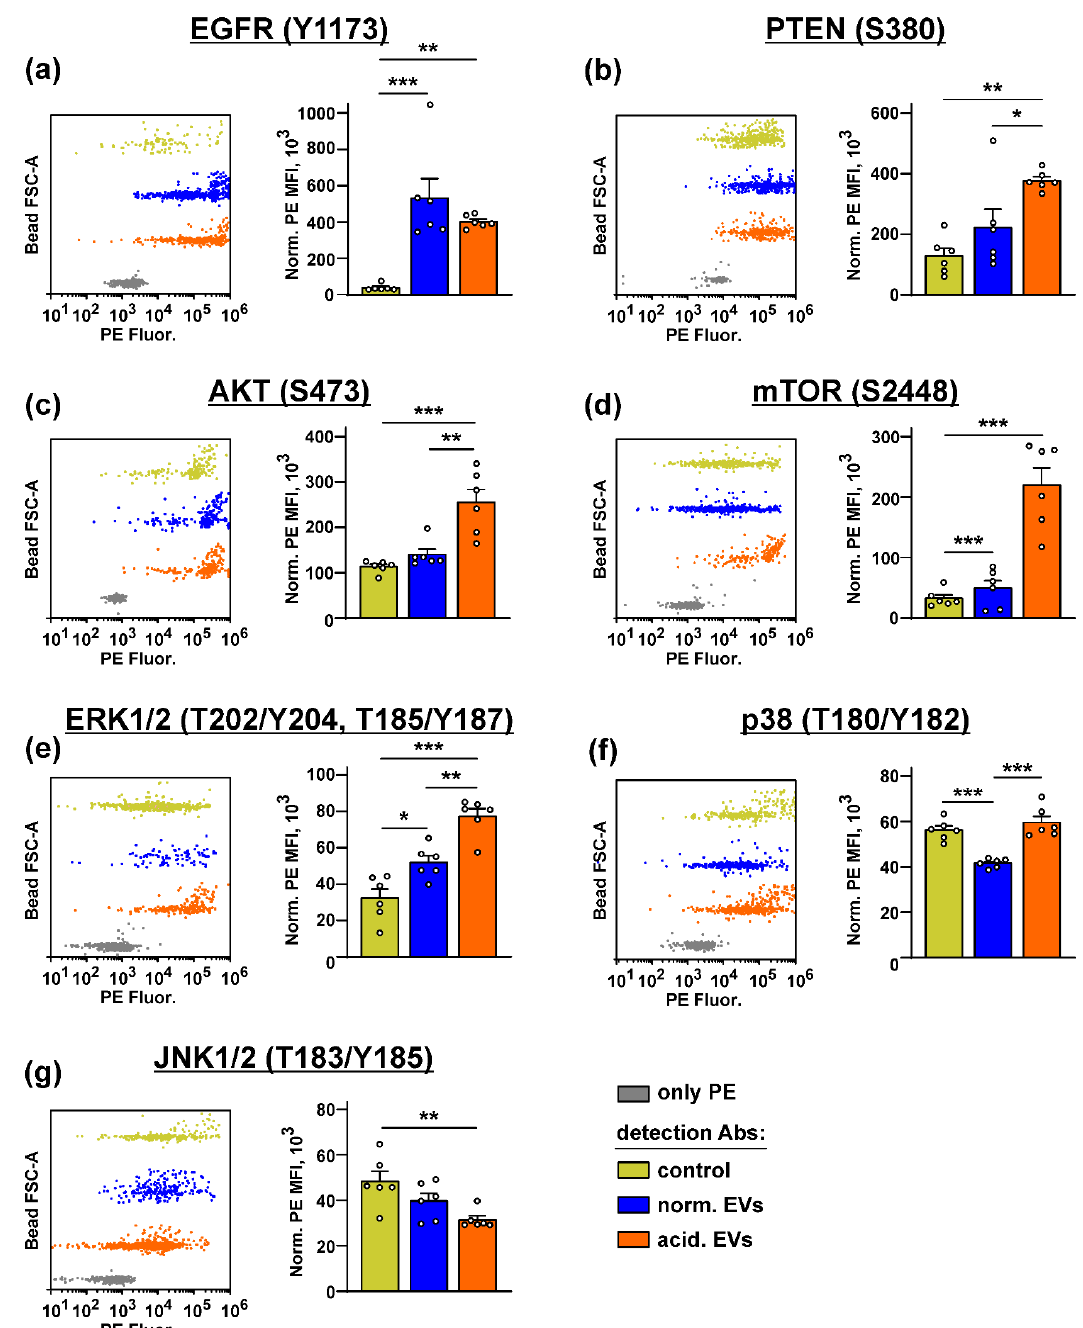
Figure 5. Influence of “normal” and “acidified” EVs on the activity of the different intracellular signaling pathways in the keratinocytes. Het1-A cells were incubated with “normal” and “acidified” EVs for 48 h, and the phosphorylation of EGFR (Y1173) ( a ), PTEN (S380) ( b ), AKT (S473) ( c ), mTOR (S2448) ( d ), ERK1/2 (T202/Y204, T185/Y187) ( e ), p38 MAP kinase (T180/Y182) ( f ), and JNK1/2 (T183/Y185) ( g ) was assayed by the Bio-Plex magnetic beads assay. Representative distributions of the magnetic beads incubated with the lysates of the untreated (control) or treated by EVs’ keratinocytes and the beads stained only by PE are shown on the left panels (every bead probe was analyzed separately and combined on the one panel for illustration). Data on the analysis of the phosphorylation level of the messengers are shown on the right panels. Data were acquired by the Attune NxT flow cytometer and presented as normalized MFI ± SEM ( n = 6). * ( p < 0.05), ** ( p < 0.01), and *** ( p < 0.001) indicate significant difference between the data groups by the one-way ANOVA followed by Tukey’s post hoc